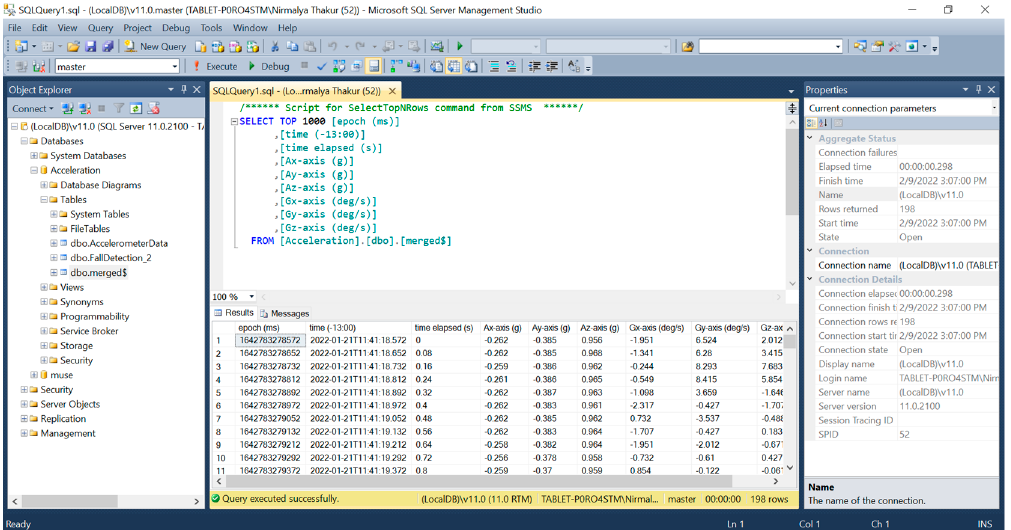
Figure 14. Screenshot from the database table in the MS SQL Server 2012 version that represents the data collected from different participants during the experimental trials. data collected from different participants during the experimental